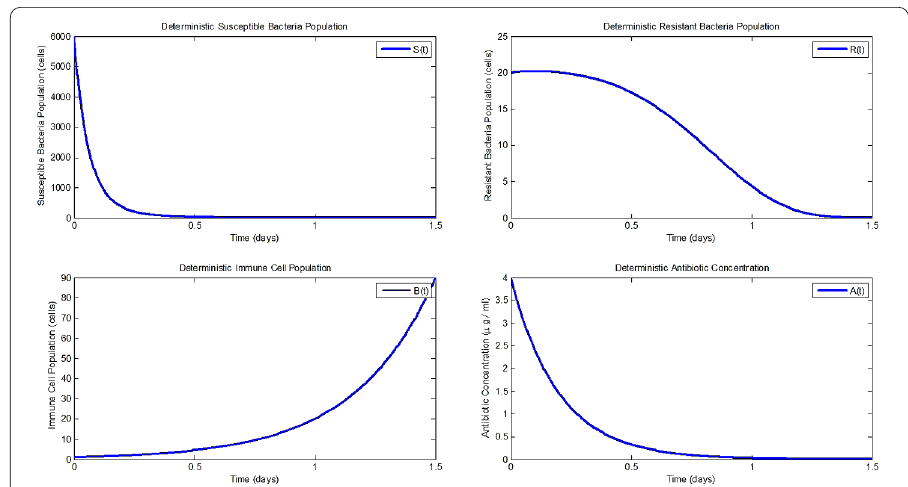
Figure 2 Solutions of the deterministic model.